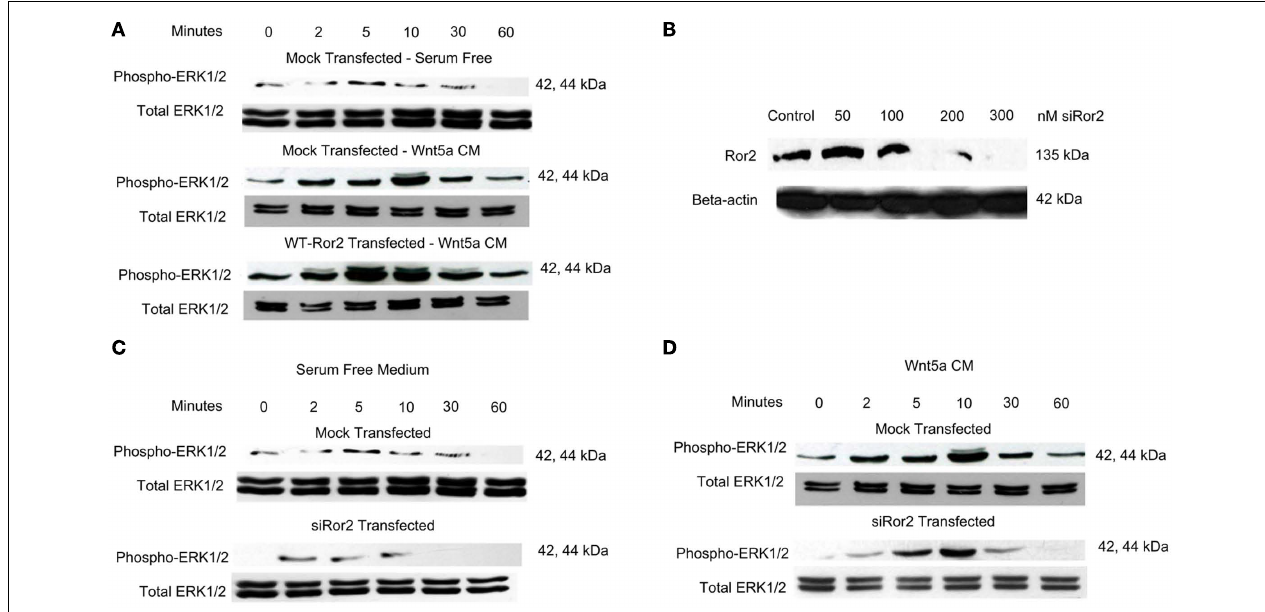
(B) HT29 cells were transiently transfected with either 0, 50, 100, 200, and 300nM siRNA Ror2 and blotted for Ror2. (C,D) HT9 cells were transfected with either siRNARor2 or no plasmid in the presence (D) or absence ofWnt5a CM for the time points listed above.Western immunoblotting for total ERK1/2 was included as an internal loading control. Blots shown are representative of three separate experiments with similar